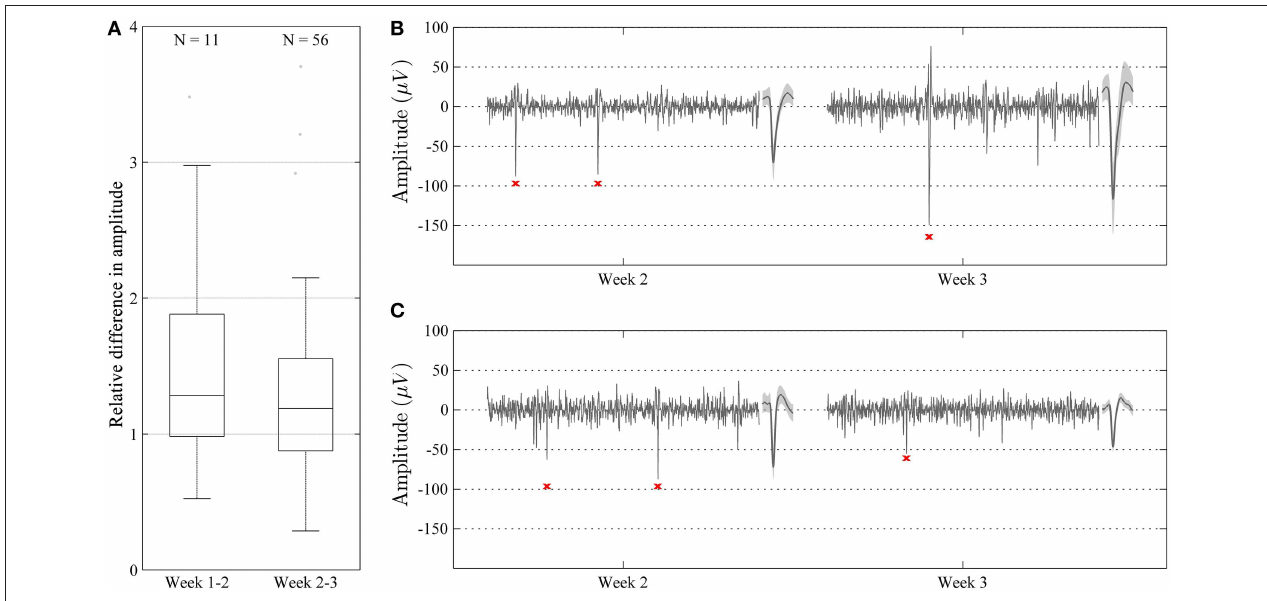
FIGURE 7 | Characterization of relative amplitudes of single unit spikes with high waveform correlation ( > 0.96) during two consecutive weeks. (A) Relative difference in amplitude shown as median and percentile values. The amplitude of units showed a tendency to increase over time, but this difference was not significant ( p > 0.05 ). (B,C) Representative recordings (100ms long) during week 2 and 3 in two different animals. Recordings are made from the same channel and show highly correlated units (waveform correlation > 0.96). Mean waveform ± standard deviation is shown to the right of each recording. In some cases, the amplitude of the units increased from week 2 to 3 (B) , whereas in some other cases, the amplitude decreased (C)